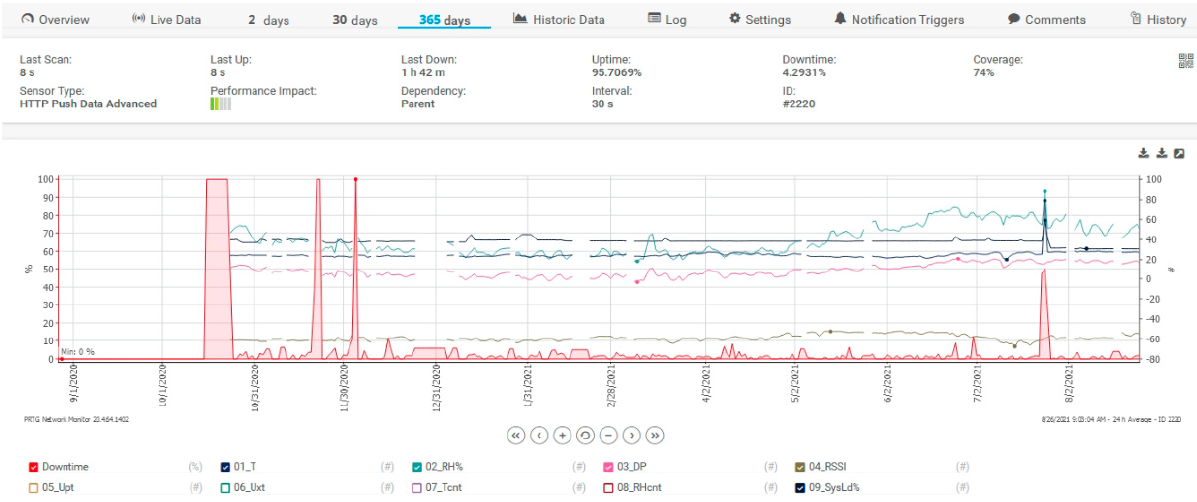
Figure 15. PRTG Server data for sensors and DownTime.